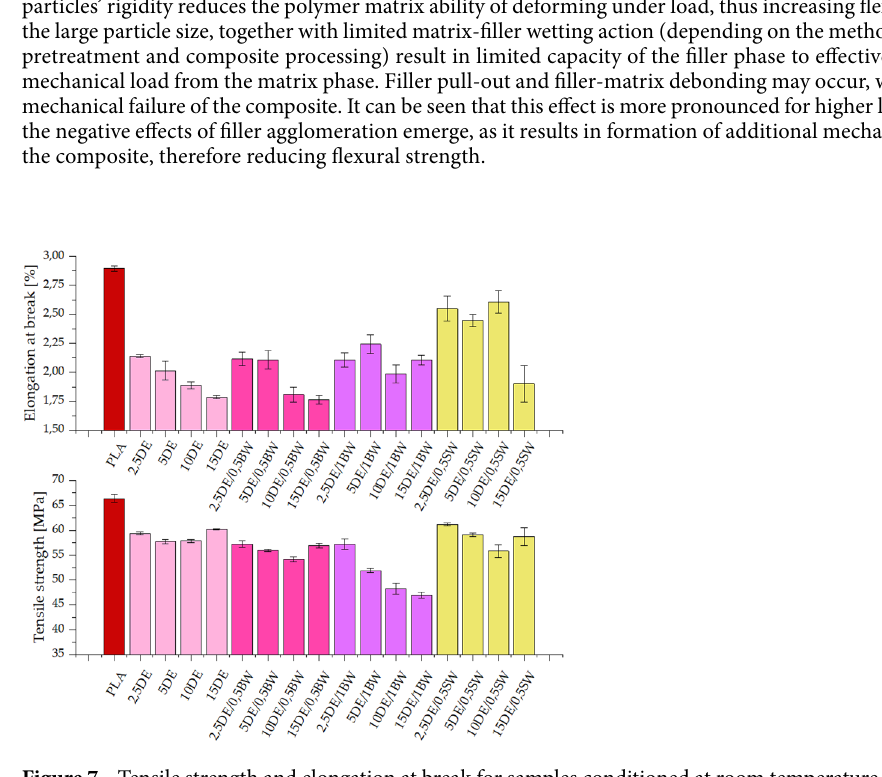
Figure 7. Tensile strength and elongation at break for samples conditioned at room